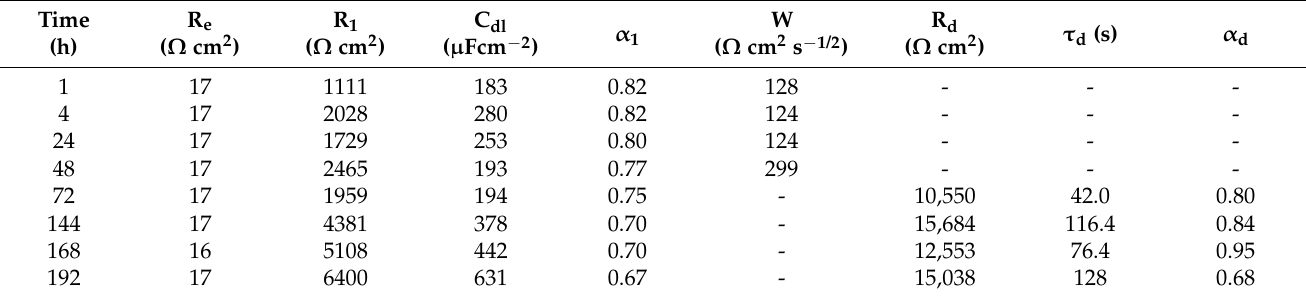
Table 5. Values of the fitting parameters for a B (as-cast) sample at different immersion times in the chlorinated solution.